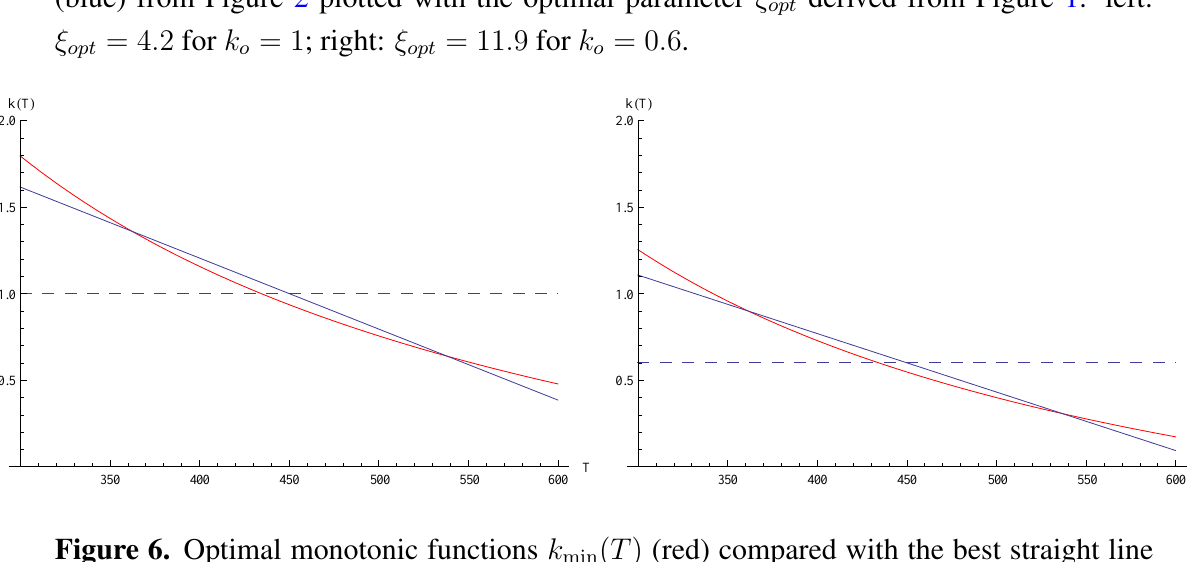
= 1 . 055 derived from opt